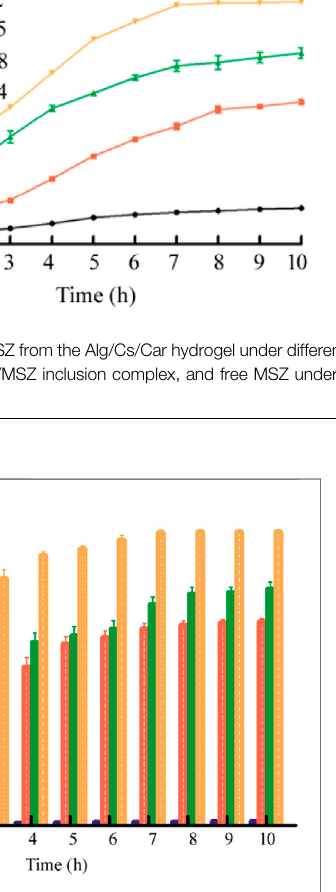
FIGURE 5 | Swelling degree of dry Alg/CS/Car microbeads beads in pH 1.2, pH 4.5, pH 6.8, and pH 7.4. Data are mean ± SD ( n (cid:2) 3) of three independent